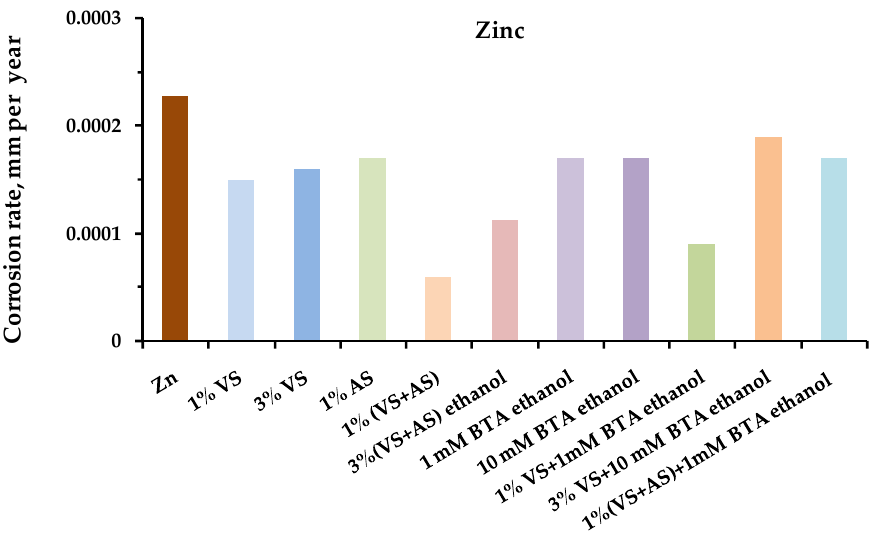
Figure 2. Atmospheric corrosion rates (mm per year) of copper modified by organosilane-based compositions. Full-scale, one-year corrosion tests, carried out in an urban atmosphere. Gravimetric assessment of corrosion magnitude.